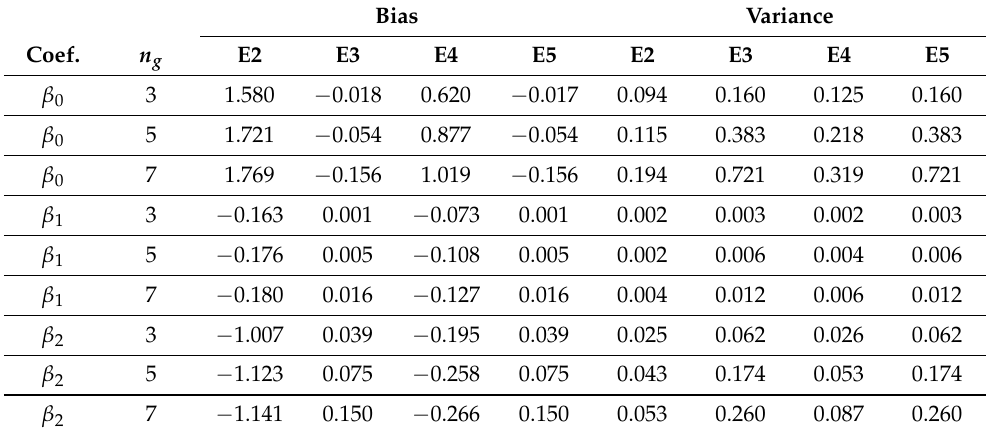
Table 3. Biases and Variances of Estimators E2 to E5 based on Aggregate-Level Y and Individual-Level X . n g is the group size in the aggregation.